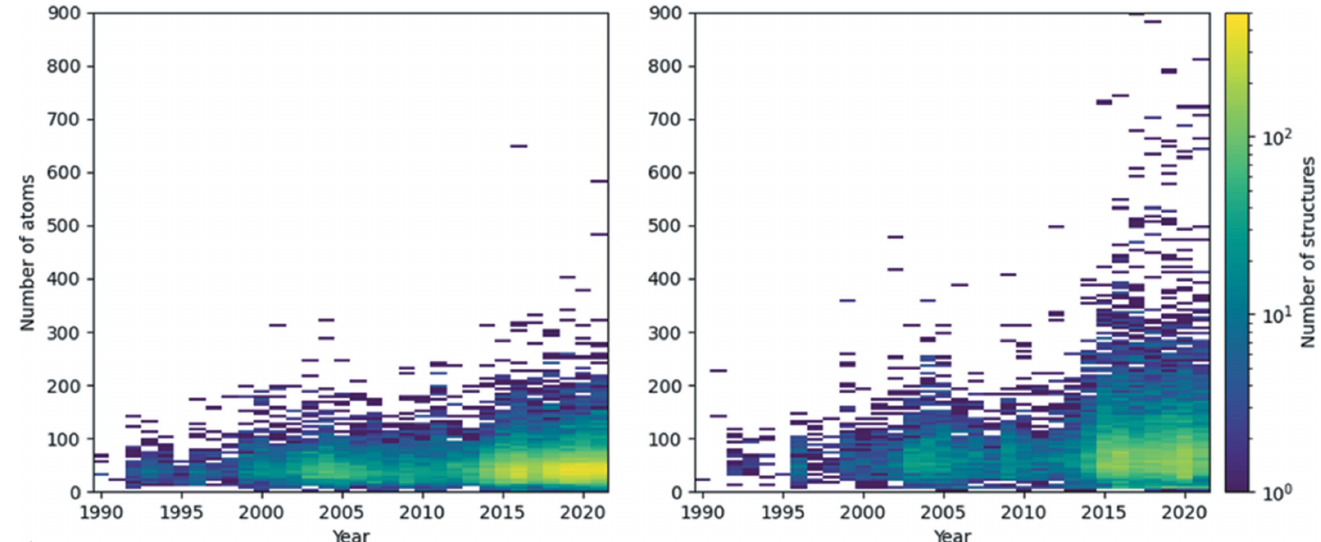
Figure 3 Frequency heat maps of the number of atoms per structure over time for organic (left) and metal–organic (right) crystal structures.